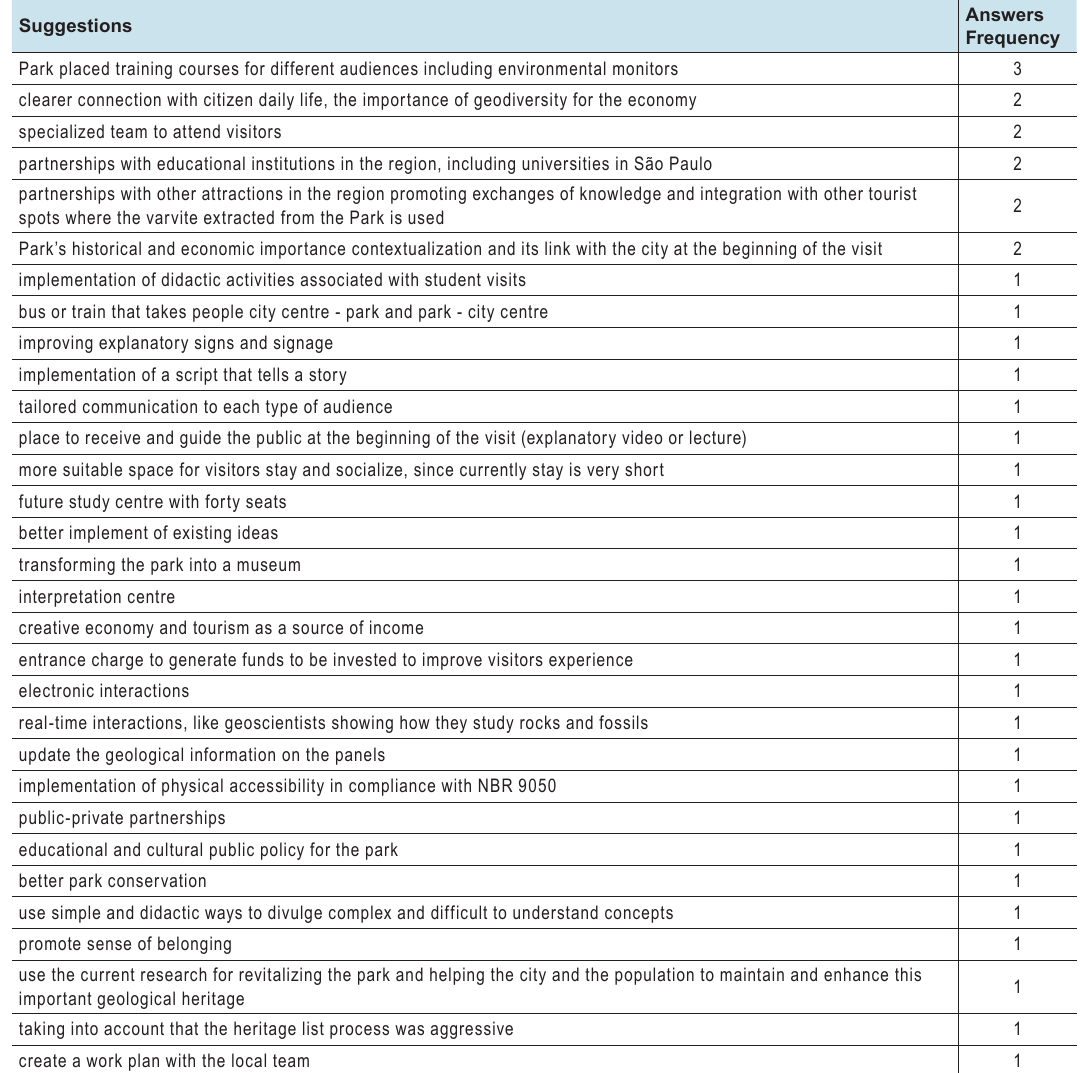
TABLE 4. Stakeholders suggestions to improve communication and the visitor experience. Suggestions